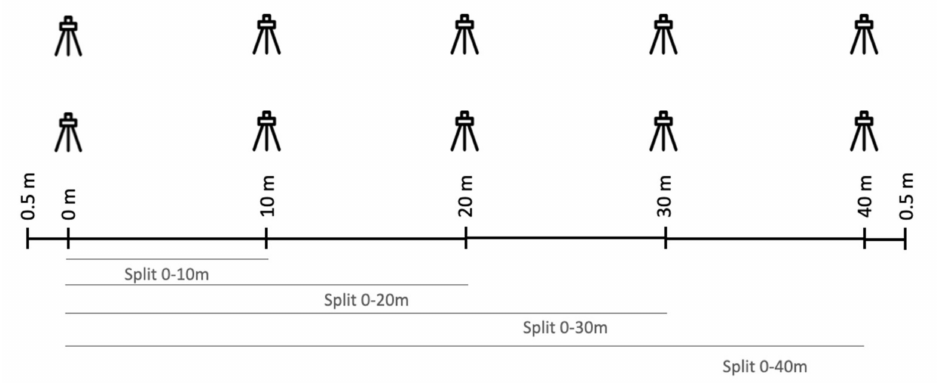
Figure 2. Diagram of the placement of the photocells in the